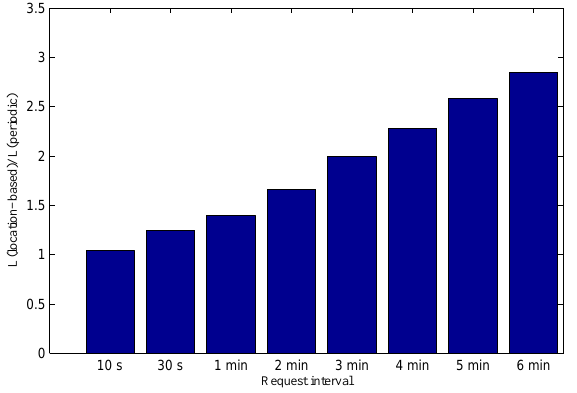
Figure 4. Network lifetime improvement vs. request